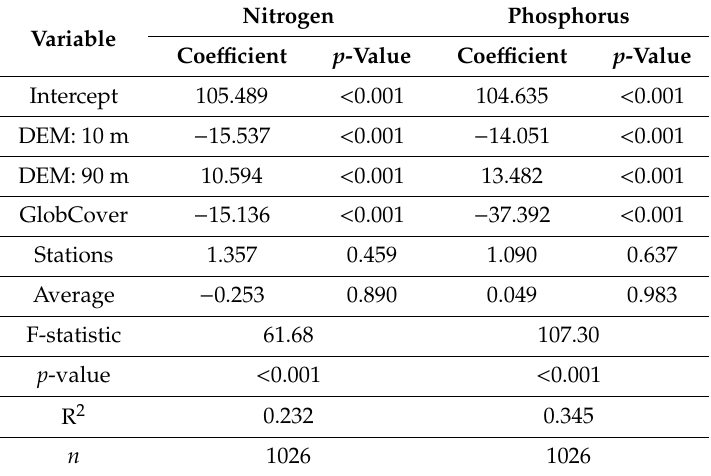
Table 4. Outputs of the multivariate linear regression models predicting the percentage change in nitrogen and phosphorus export (kg / ha / year) with respect to the Baseline Scenario for the full extent of the study area using input spatial data as independent variables (digital elevation model (DEM), land cover, and precipitation).